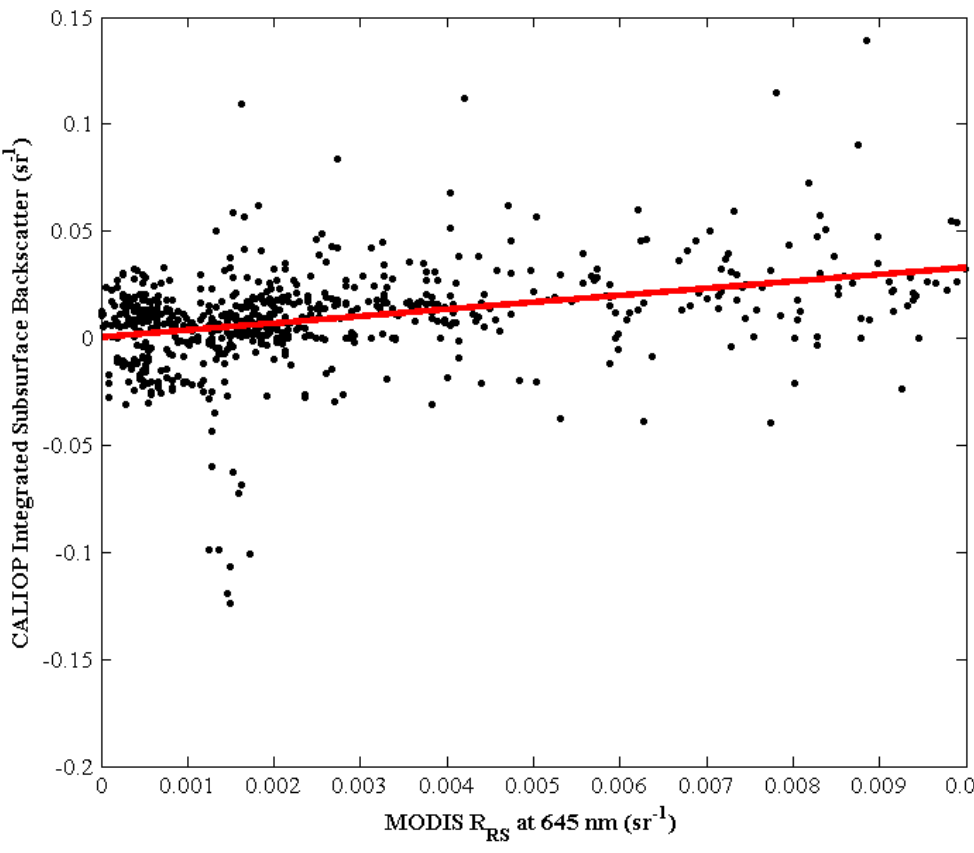
Figure 10. Scatter plot of CALIOP 532 nm integrated subsurface backscatter and MODIS 645 nm remote sensing reflectance. The Pearson’s correlation coefficient is 0.11. The exceptionally low points ( γ < − 0.05 sr − 1 ) are all from 07 May 2007, from points of low u transmittance. Fourteen outliers identified with Peirce’s criterion with γ not